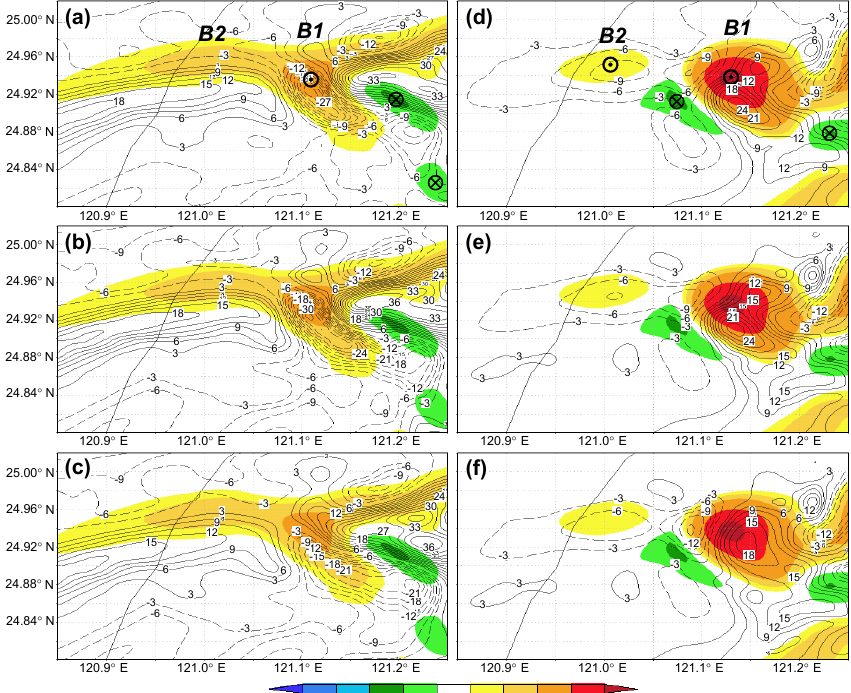
Figure 13. Model-simulated w (ms − 1 , color, scale at bottom) and Laplacian of perturbation pressure (10 − 6 Pam − 2 , contour, every 3 × 10 − 6 Pam − 2 , dashed for negative values) of cells B1 and B2 at (left) 806m and (right) 2929m at 21:00UTC on 11 June 2012. (a, d) ∇ 2 p (cid:48) obtained from separation method; (b, e) ∇ 2 p (cid:48) = ∇ 2 p (cid:48) and downdraft centers are labeled in panels (a) and (d)